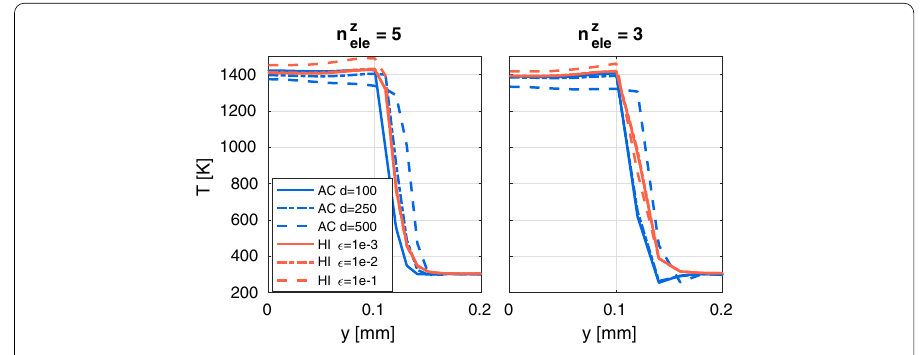
Fig. 24 Surface temperature profiles for AC with different phase change intervals transverse to laser path at x = 0 . 2mm showing transition from solid to powder